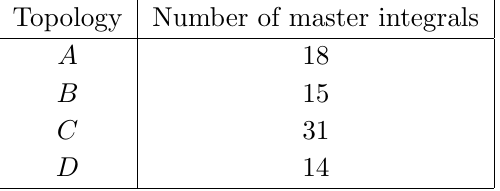
Table 1 . The number of master integrals for a given